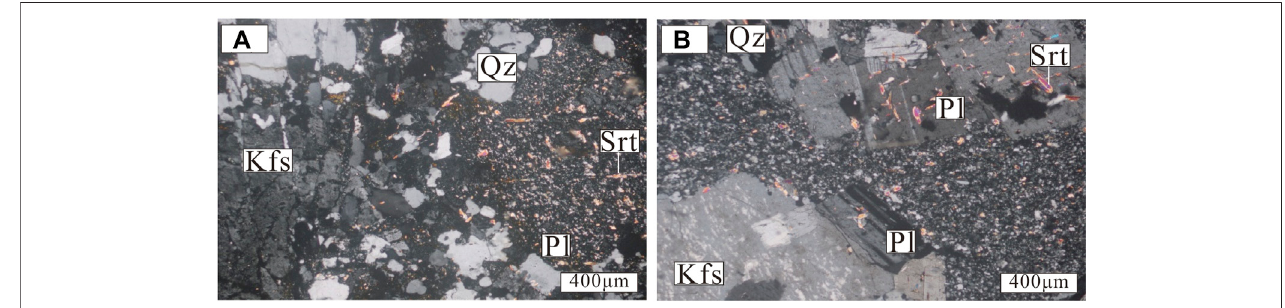
FIGURE 3 | Photomicrographs of the granite dyke (Sample 1725) (A) and the granitic porphyry dyke (Sample 1717) (B) Qz-quartz; Pl-plagioclase; Kfs-potash feldspar; Srt-sericite.